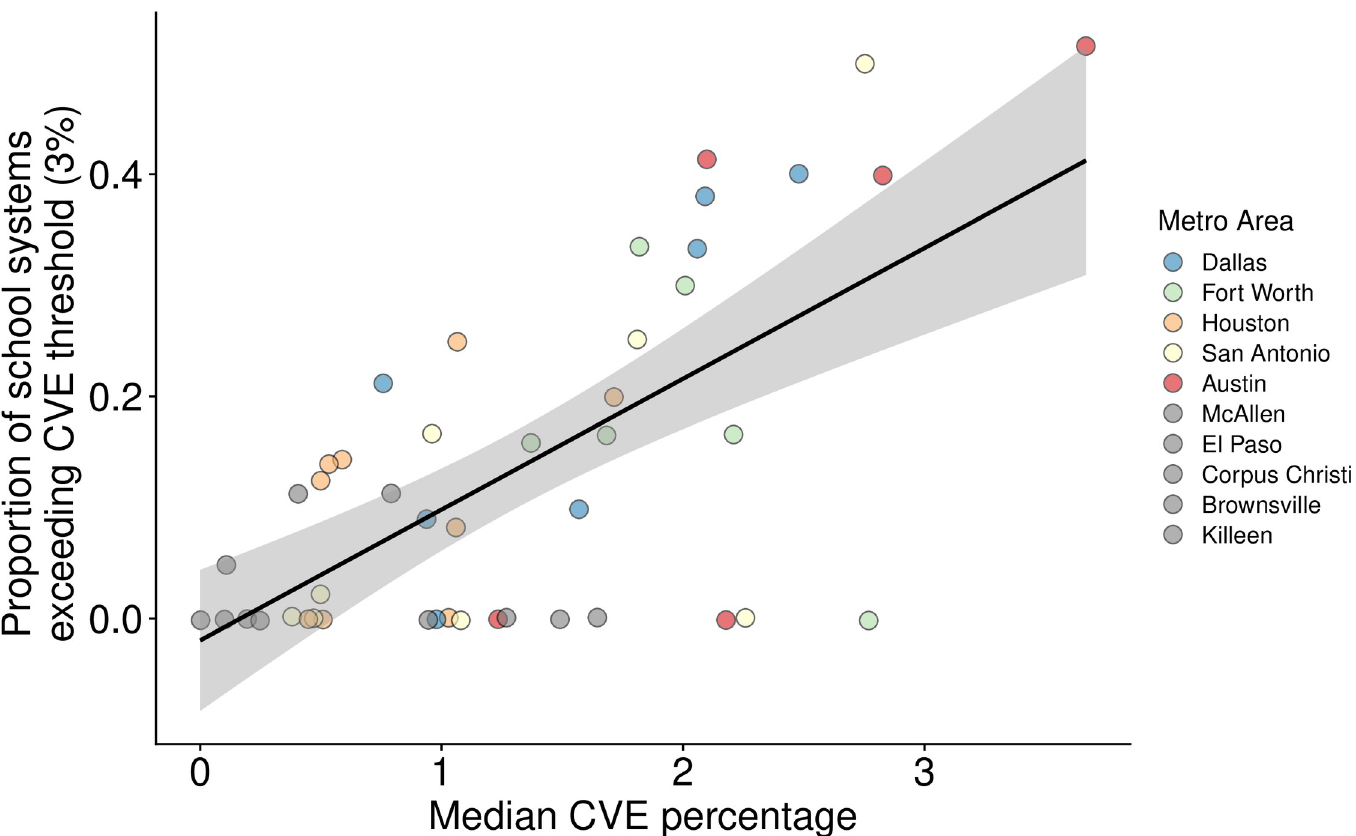
Fig 3. Median CVE percentages versus the proportion of school systems at high risk for outbreaks within the metropolitan counties of Texas. For each county (black points) we compared the median CVE percentage across all school systems in the county to the proportion of school systems in the county reporting CVEs over 3%. The black line indicates the best linear fit to the data and the gray band indicates its 95% confidence interval (Adjusted R 2 = 0.43, P < 0.0001). CVE, conscientious vaccination exemption.